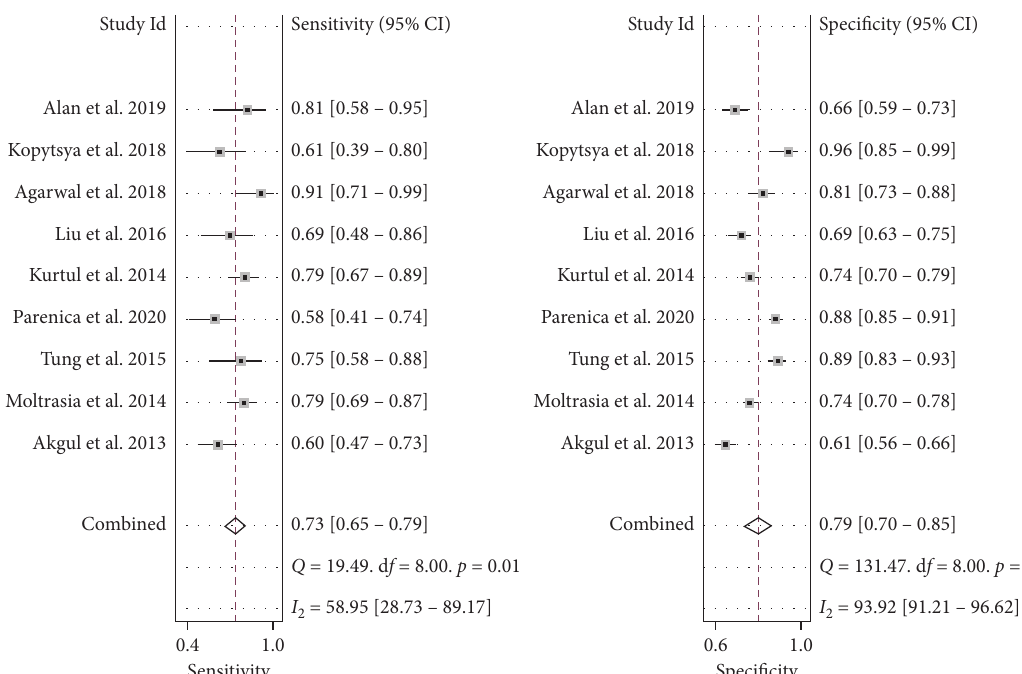
Figure 3: Forest plot of the sensitivity and specificity of brain natriuretic peptide for the diagnosis of contrast-induced acute kidney injury in patients with acute coronary syndrome undergoing coronary angiography. The pooled SEN and SPE values were 0.73 (95% CI 0.65–0.79) and 0.79 (95% CI 0.70–0.85), respectively. SEN, sensitivity and SPE, specificity.